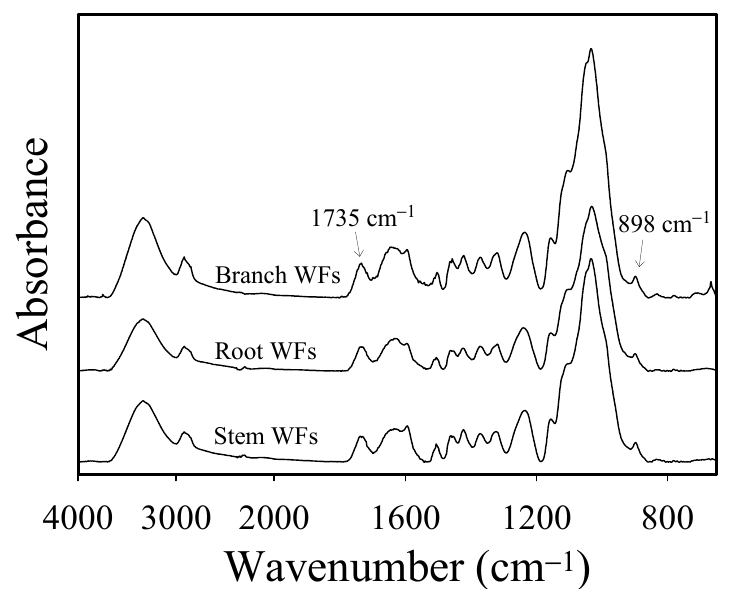
Figure 1. ATR-FTIR spectra of WFs from various pomelo tree parts.